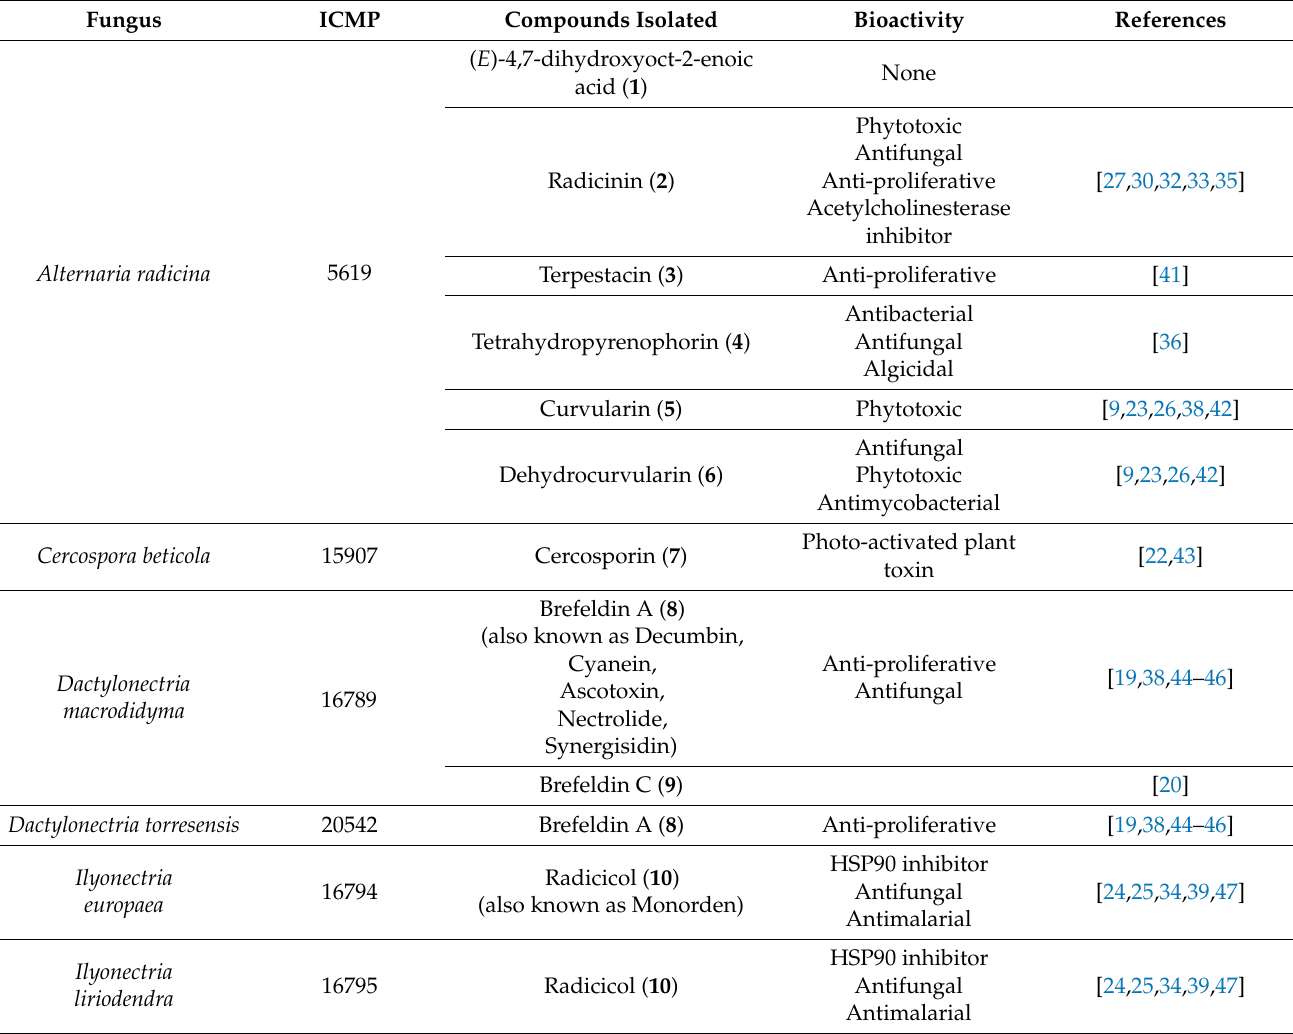
Table 2. Summary of natural products 1–10 isolated from fungal pathogens.